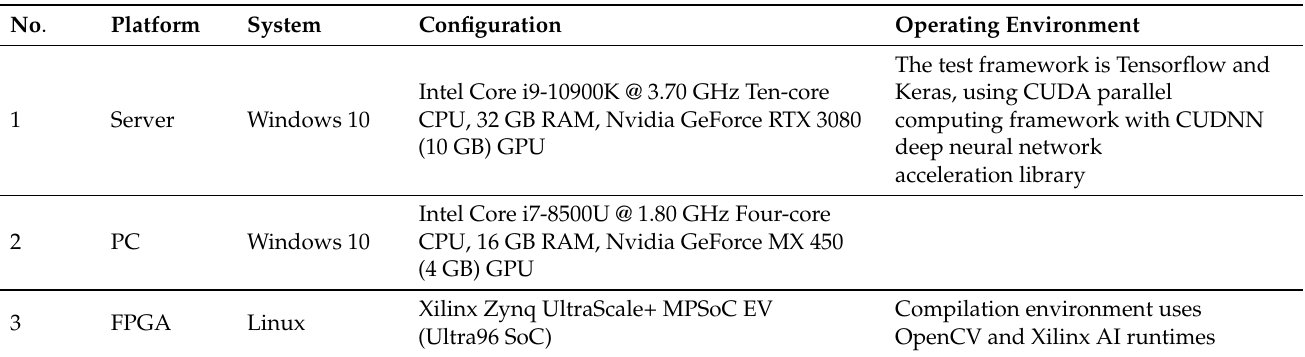
Table 2. Configuration environment for different test